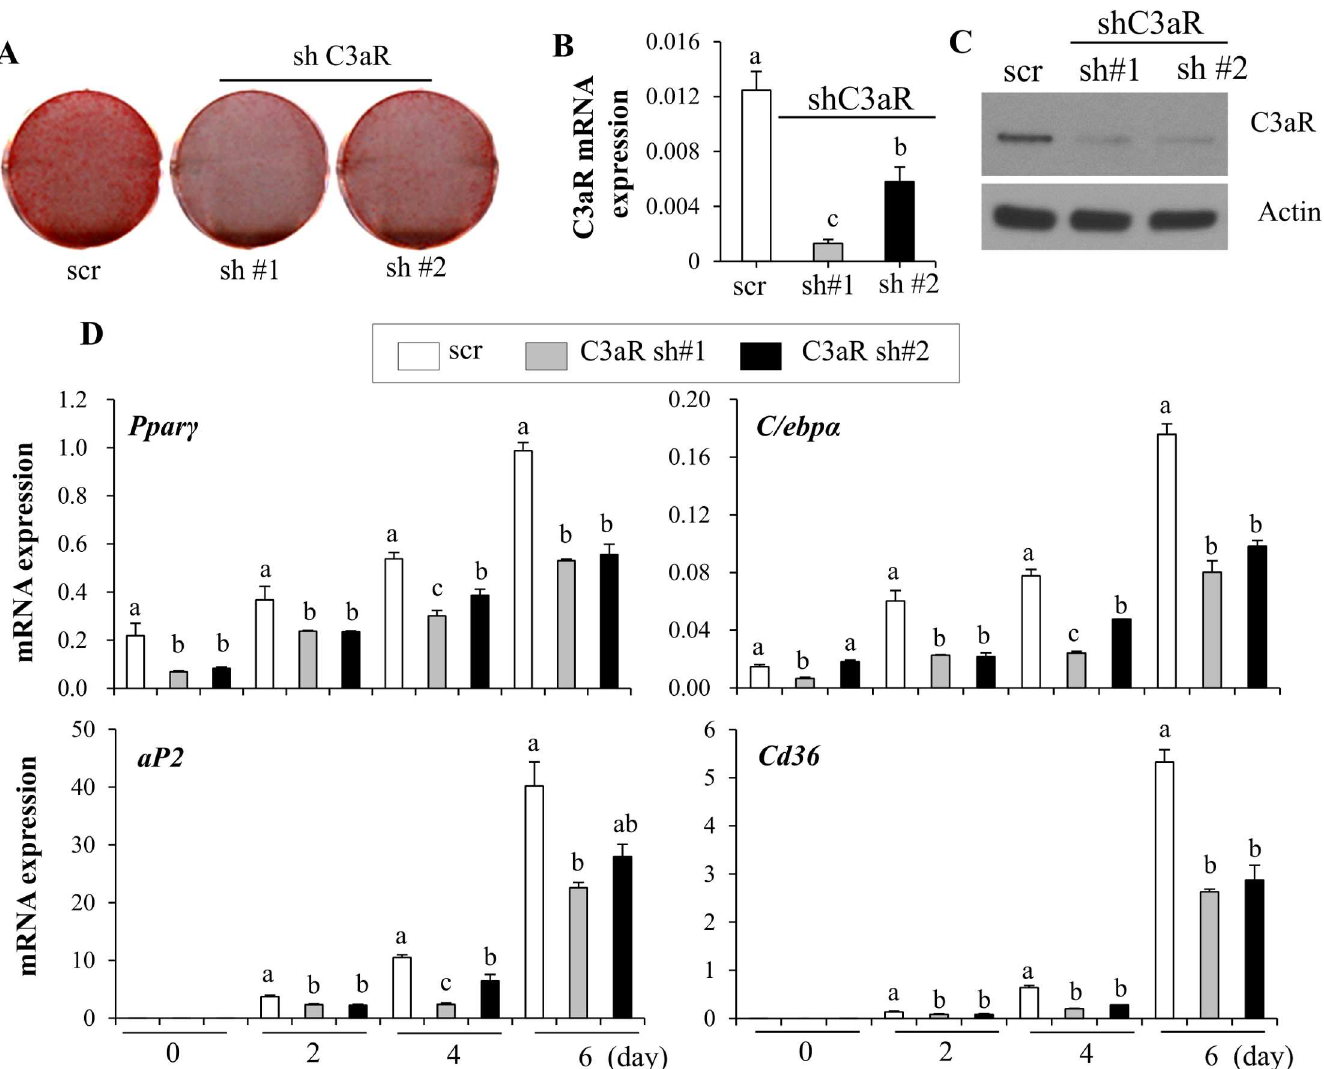
Fig 6. C3aR signaling is essentialfor adipocyte differentiation. ( A ) Knockdown of C3aR inhibitsadipocytedifferentiation. C3H10T1/2cells were infected with virusharboring two independent shRNAs againstC3aR or scrambled shRNA (scr)and stable cells were selectedwith puromycin(2 μ g/ml) for 2 weeks. Stable C3H10T1/2cells were differentiated into adipocytesand lipid accumulationwas assessed by Oil red O staining.( B ) Two independent shRNAs effectively reduceC3aR mRNA expression. ( C ) C3aR proteinexpression in control and C3aR knockdown cells was measuredby western blotting. ( D ) Expression of Ppar γ , C/ebp α , aP2 , and Cd36 in C3aR-deficientC3H10T1/2 cells was measuredby real timePCR analysis. Data are presentedas means +/- s.d. and are representative of two independent experiments. Each independent experimentwas carriedout in